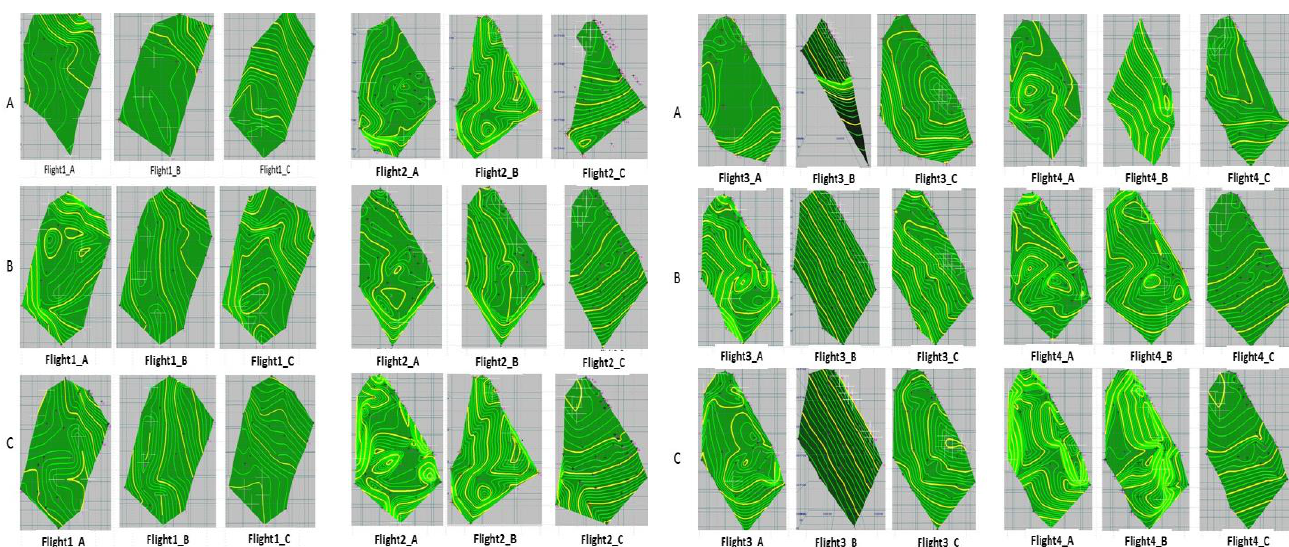
Figure 12. The error distribution in each